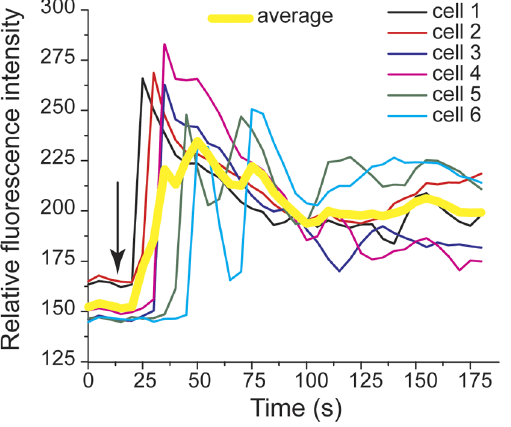
Figure 4. Time course of antigen-stimulated Ca 2 + mobilization in individual RBL-2H3 cells. Mobilization was assessed in micro- fluidic channels using calcium indicator Fluo-3. The arrow indicates the time at which the antigen (DNP-BSA) reached the cells in the region of the microfluidic device under observation.